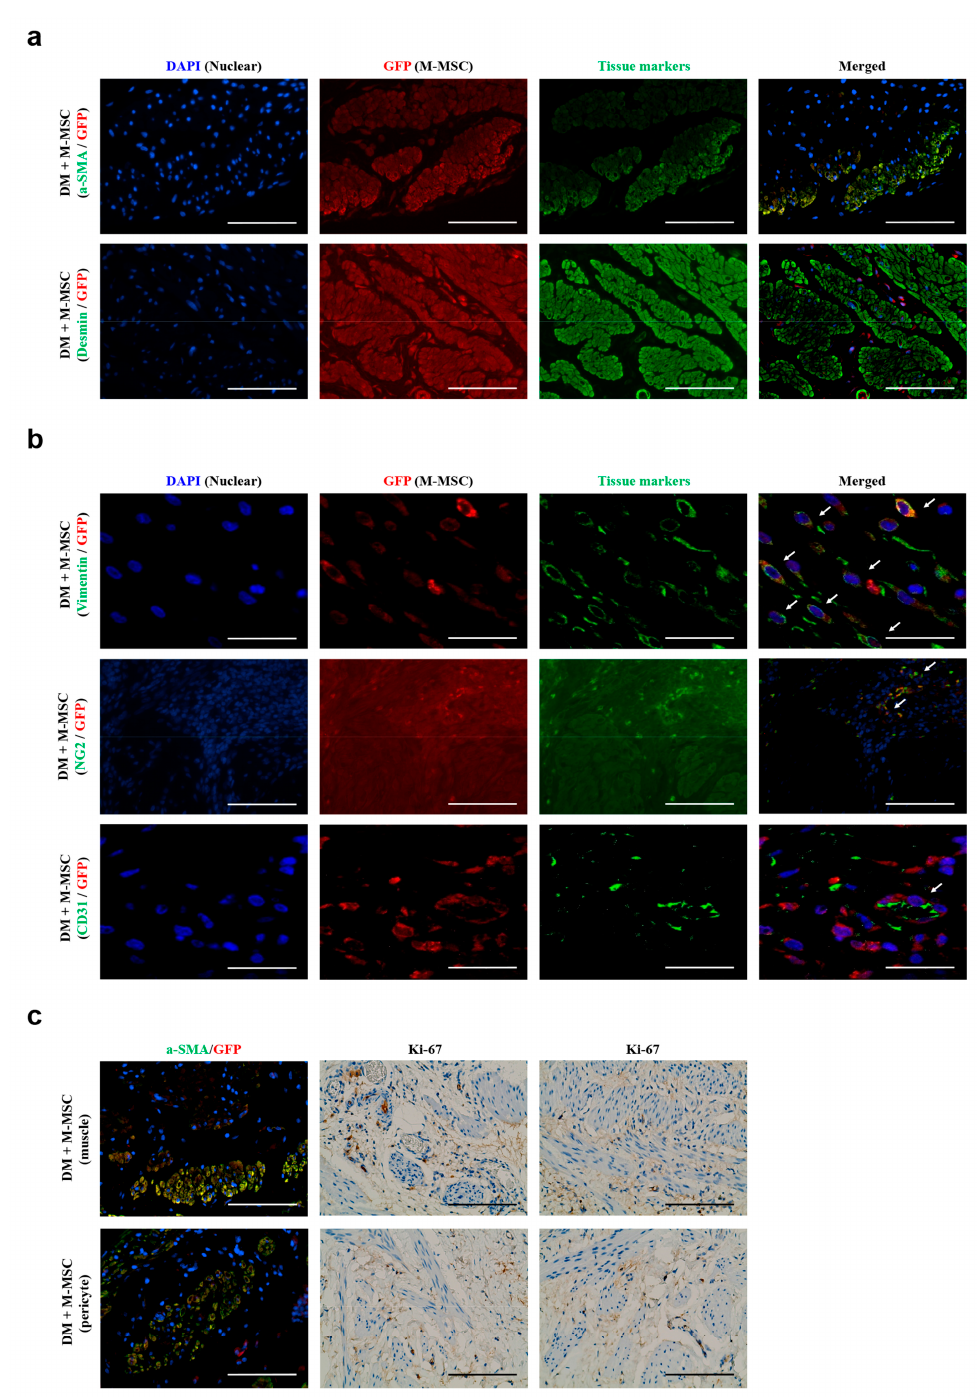
Figure 6. Cellular fate of transplanted M-MSCs. Co-immunofluorescence staining of M-MSCs stably expressing GFP (red) with ( a ) muscle-specific markers ( α -SMA and desmin) and ( b ) pericyte-specific markers (vimentin and NG2) and an endothelial marker (CD31) in bladder sections of DM + M-MSC (1000 K) rats at 1 week post-transplant (400× magnification; scale bar, 100 µm). Arrows indicate GFP + engrafted cells co-expressing each tissue marker. ( c ) Proliferation status of engrafted M-MSCs was examined by immunohistochemical staining for the human specific Ki-67 marker of cell proliferation (400× magnification; scale bar, 100 µm). Nuclei were stained with DAPI (blue, ( a , b )) or Mayer’s hematoxylin ( c ). Representative images of co-immunofluorescence staining for GFP and α -SMA proteins are depicted in the left panel of the Ki-67 immunohistochemical staining results.